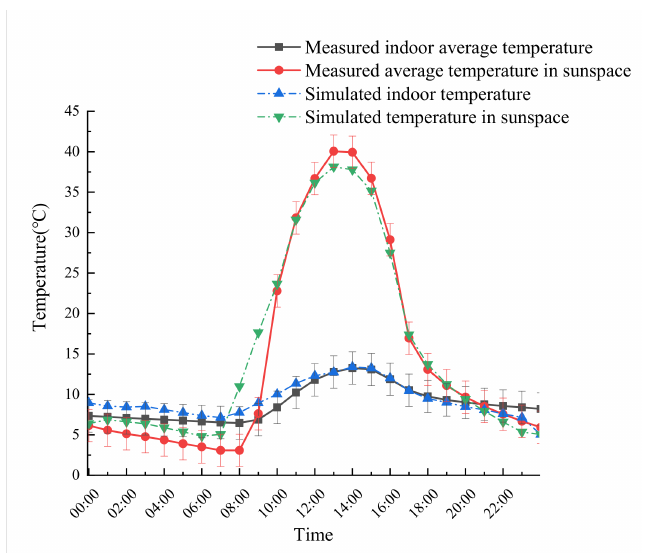
Figure 6. The comparison of simulated and measured